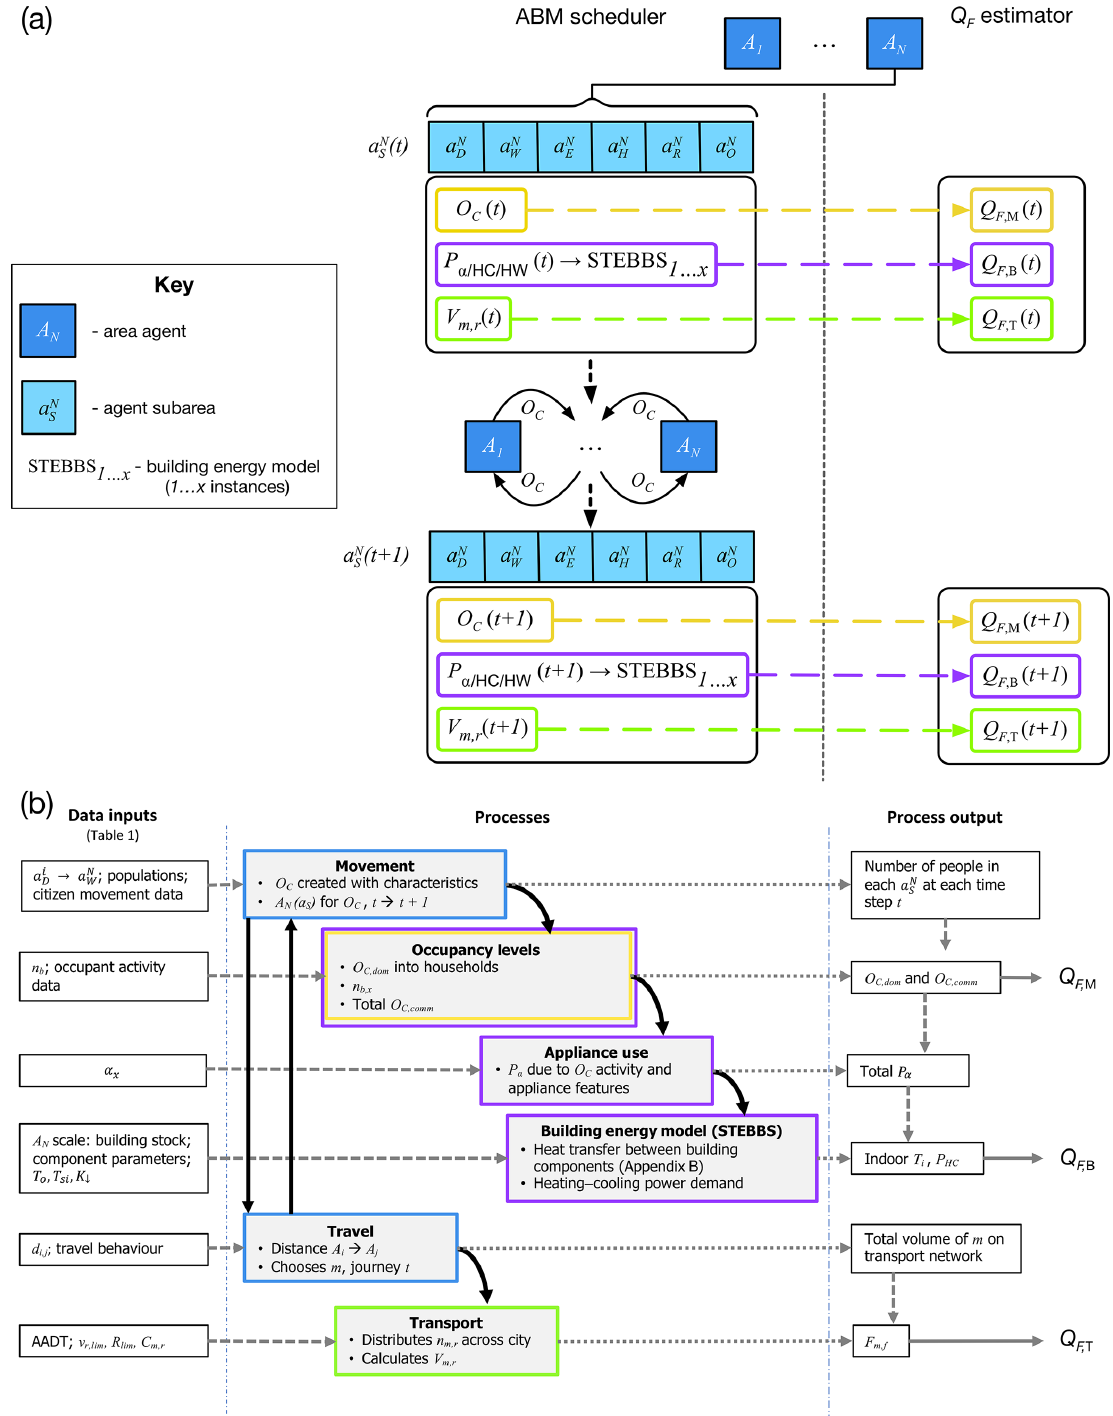
Figure 1. Overview of DASH (a) Agent–agent interaction and estimation of Q F with the A N (mid blue) to a N changes in process outputs (yellow, purple, green) between time steps and the reaction (arrows) to give Q F . (b) Processes include agent– agent interactions (blue boxes), agent reaction and interaction with environment ( Q F, B : purple; Q F, M : yellow; Q F, T : green boxes), inputs (dashed lines), process outputs (dotted lines) and their interactions (thick lines), and Q F outputs (solid grey lines). Notation list gives